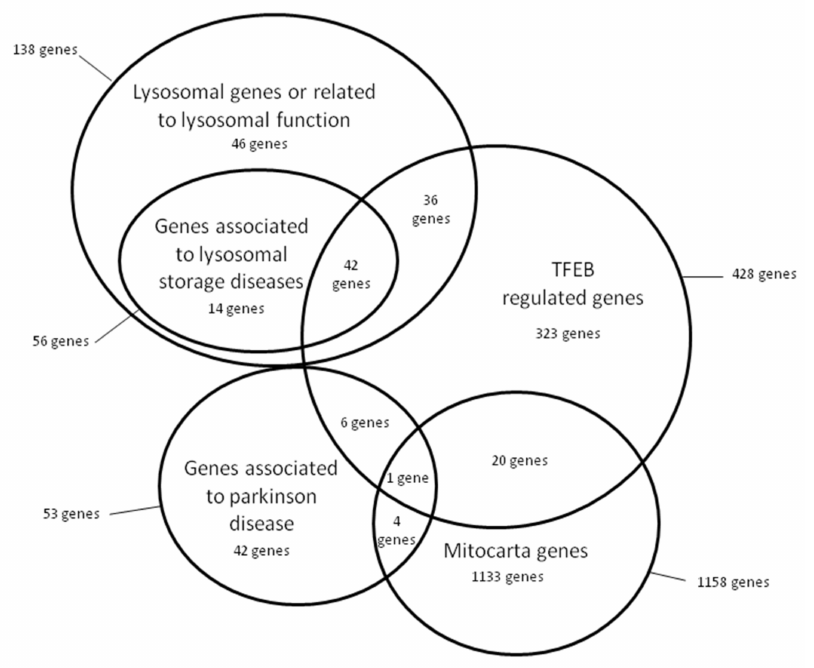
Figure 2. Graphical representation by groups of the 1667 genes analysed in this study and the intersection among